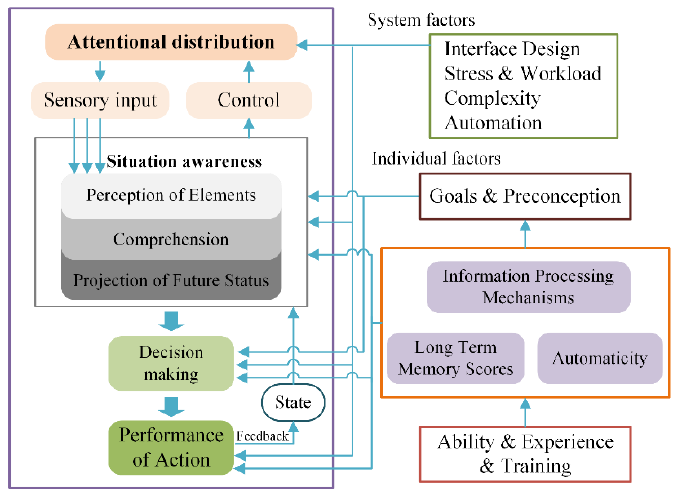
Figure 1. Situation awareness model.